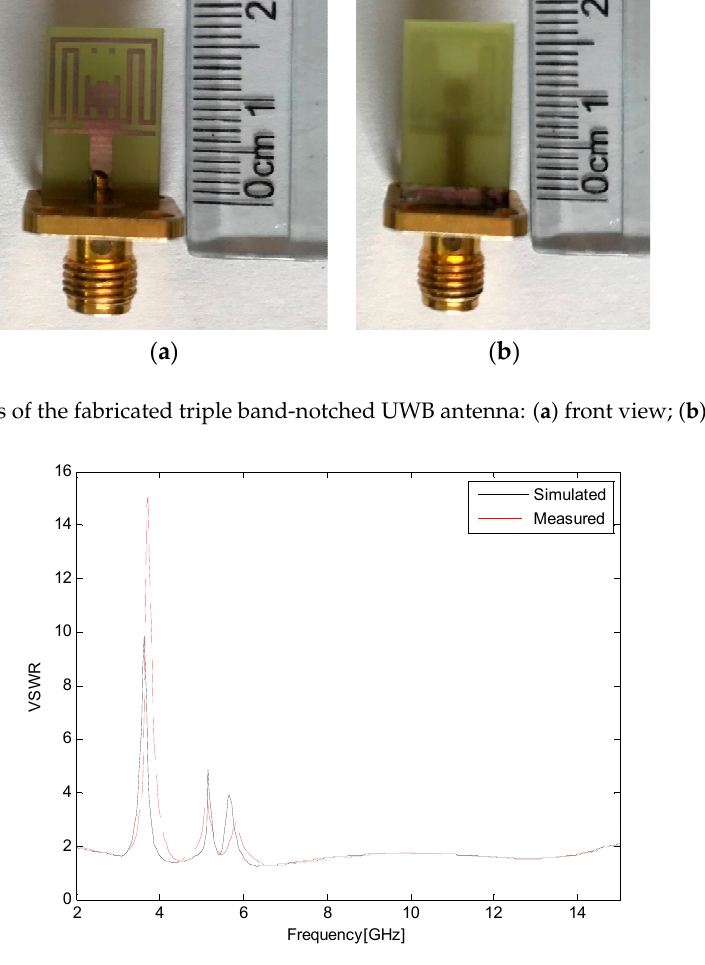
Figure 11. Simulated and measured VSWR of the proposed triple band-notched UWB antenna.